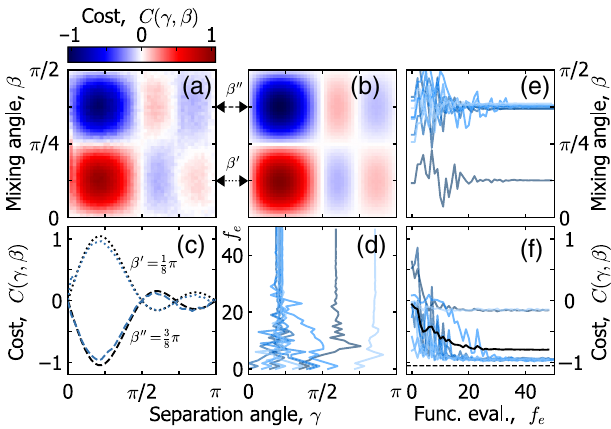
FIG. 3. Cost function evaluated for p = 1 on the three-qubit problem instance using C Z φ gates. (a) Cost-function landscape as a function of variational parameters. (b) Cost-function land- scape obtained from noise-free simulations. (c) Experimental evaluation (blue) and simulation (black) of the cost function for two horizontal line cuts of (a),(b), with β (cid:9) = π/ 8 (dotted lines) and β (cid:9)(cid:9) = 3 π/ 8 (dashed lines), respectively. (d),(e) Ten convergence traces of the separation angle and the mixing angle, respectively, for end-to-end optimization starting from random parameter initialization. (f) Average energy (solid black line) and individual convergence traces (faded blue lines) of the energy corresponding to parameters shown in